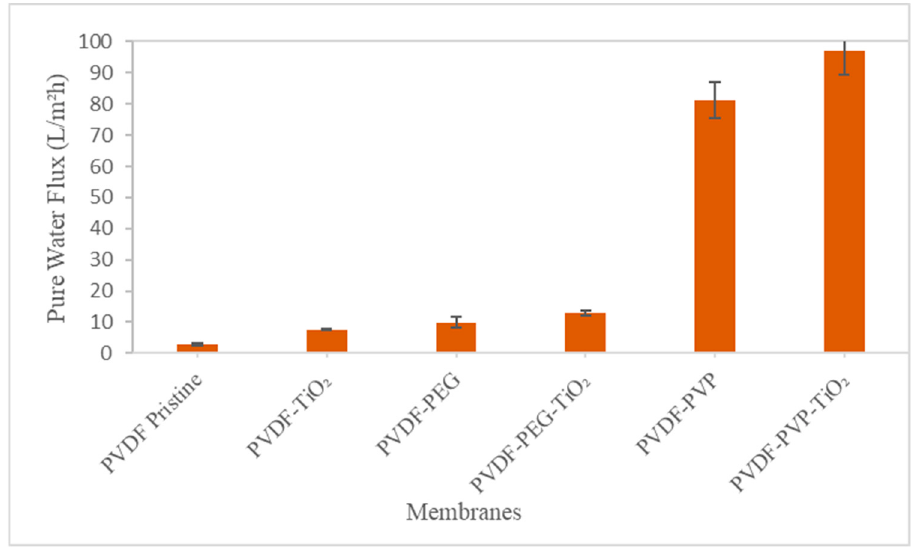
Figure 6. Pure water flux of membranes.